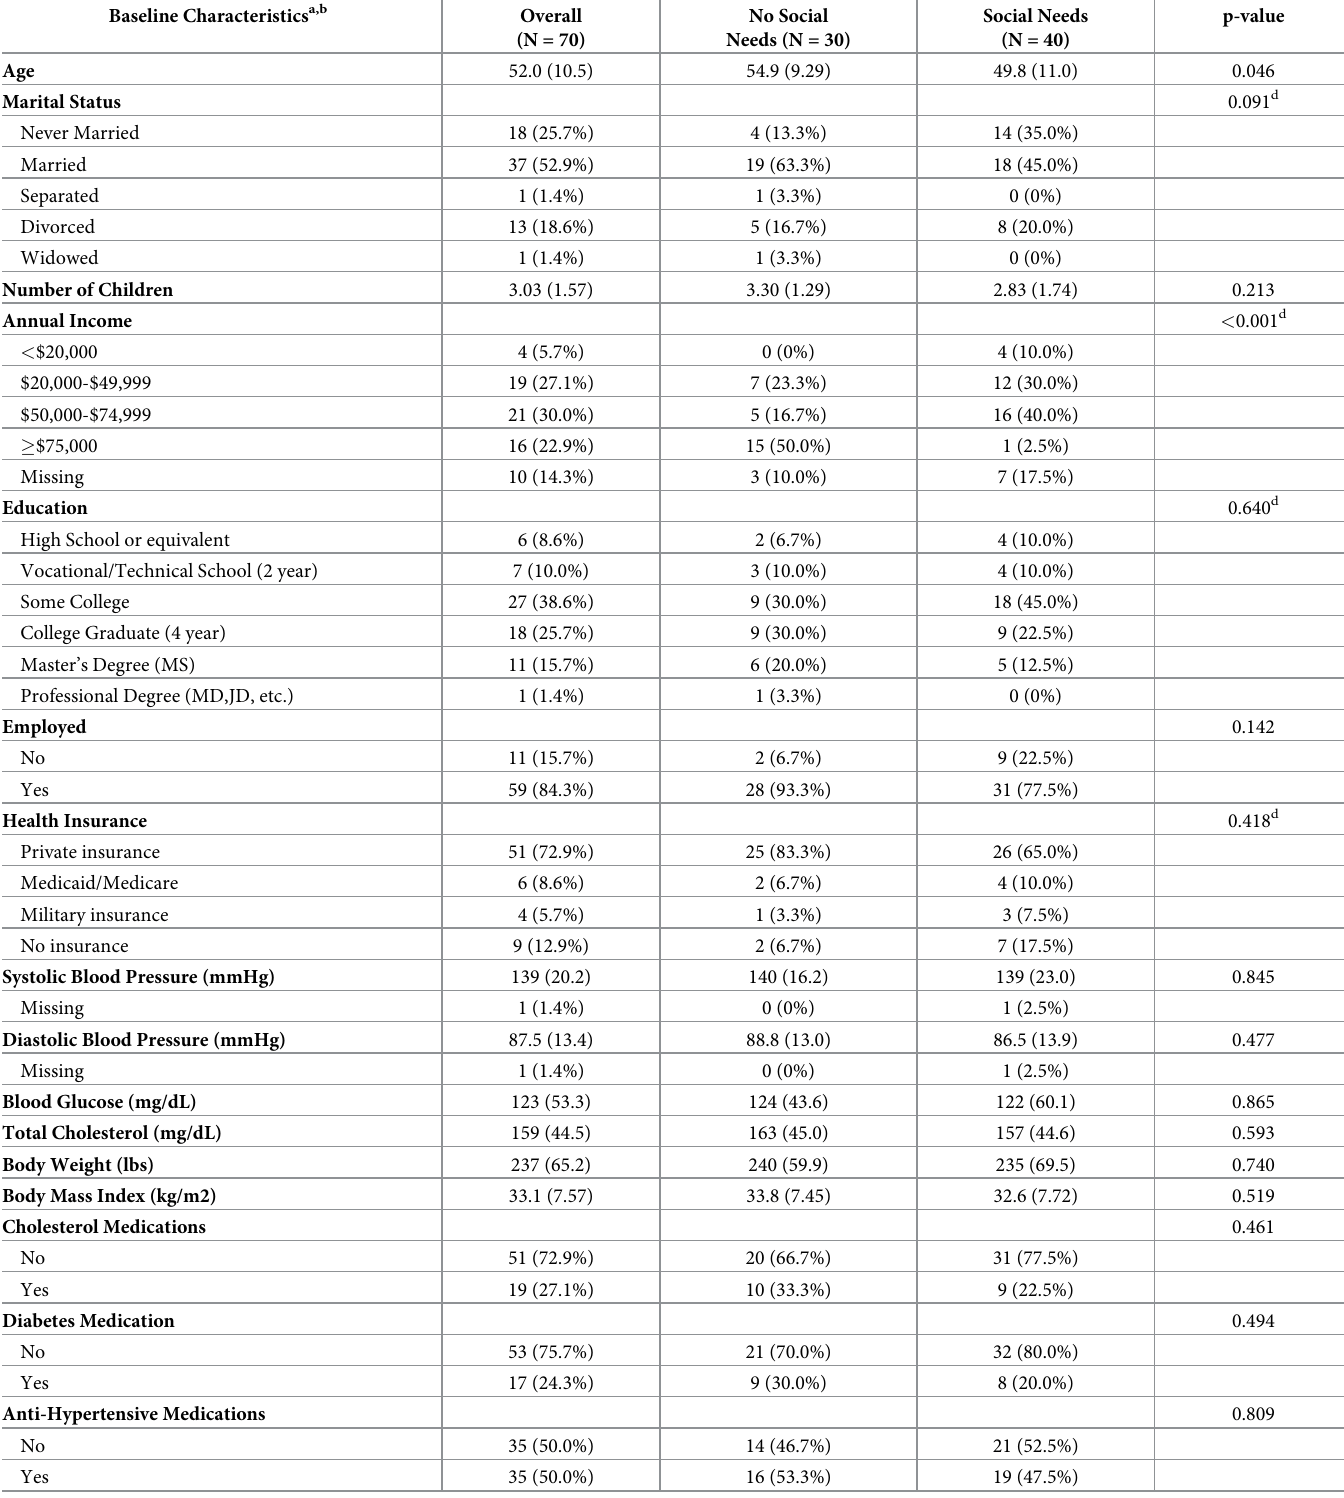
Table 1. Characteristics of participants in the black impact pilot study by baseline non-medical health related social needs at